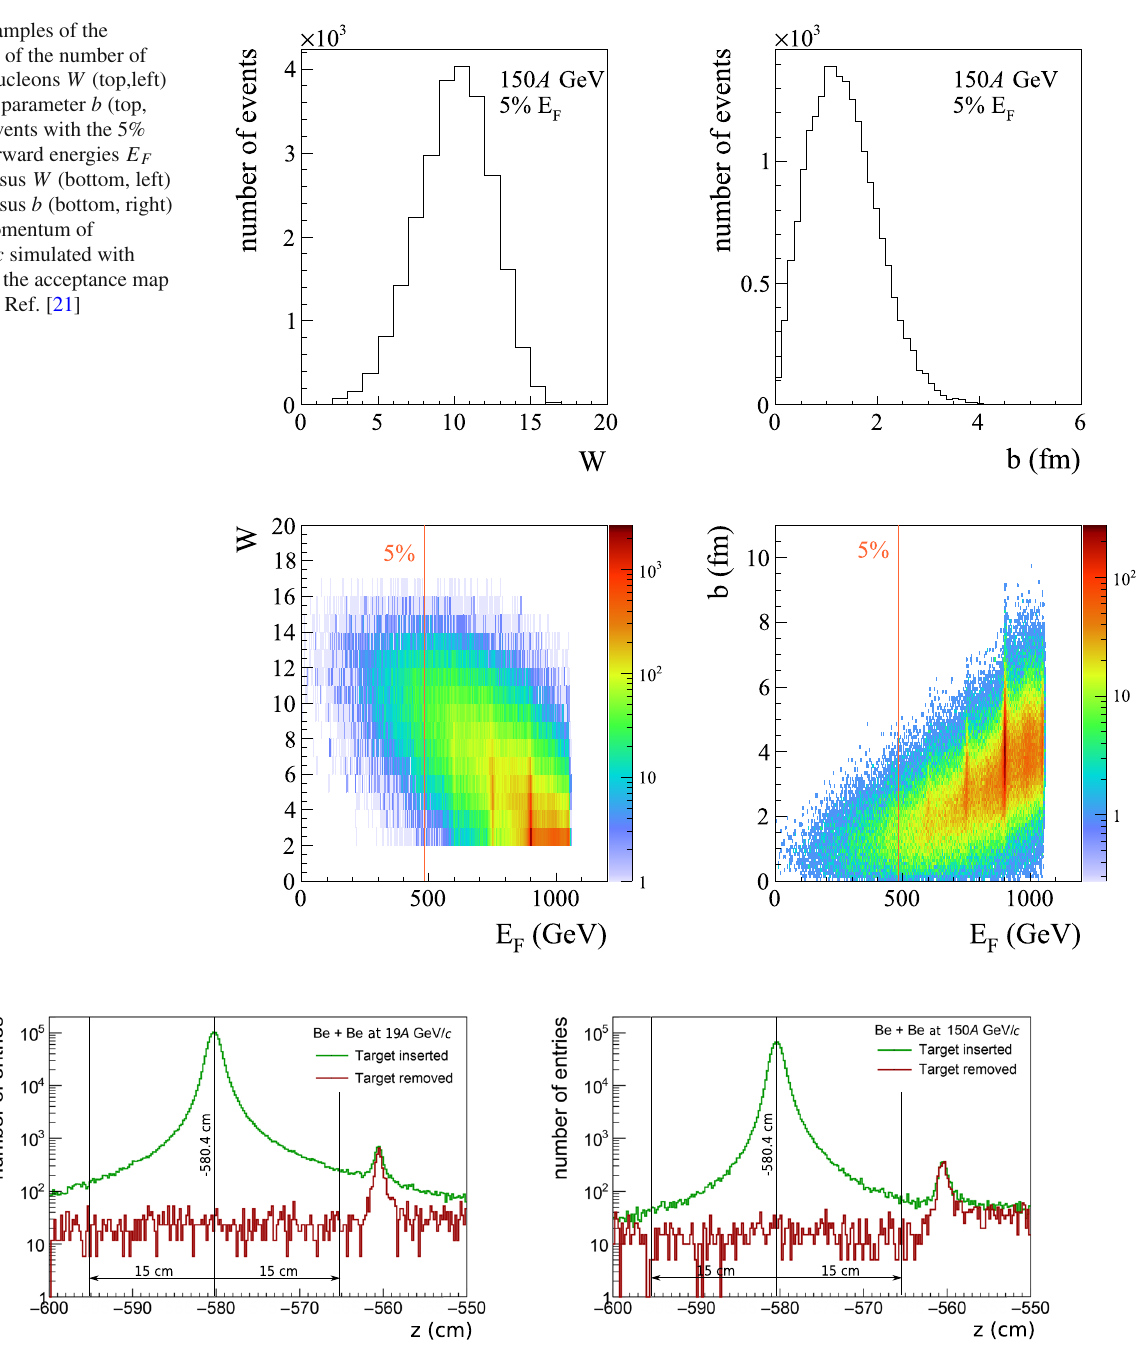
Fig. 9 Distribution of fitted vertex z coordinate for the 20% most central 7 Be + 9 Be interactions with target inserted (green histogram) and target removed (red histogram). (Left): 19 A GeV / c . (Right): 150 A GeV / c . Target position and cut values are marked. Target is